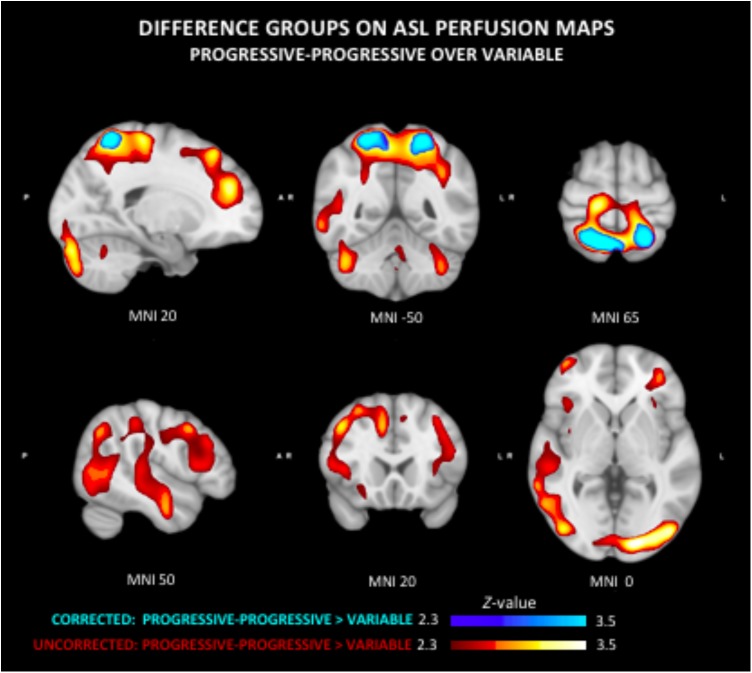
Group differences in arterial spin labeling (ASL) perfusion measures. The progressive-progressive (PP) group shows regional higher perfusion values as compared to the variable (V) group in both the uncorrected and corrected flow maps. This difference can be clearly seen in the corrected flow maps in the parietal regions including the precuneus. The PP group similarly shows significantly higher perfusion than the V group within the parietal lobe, but also temporal and frontal regions.